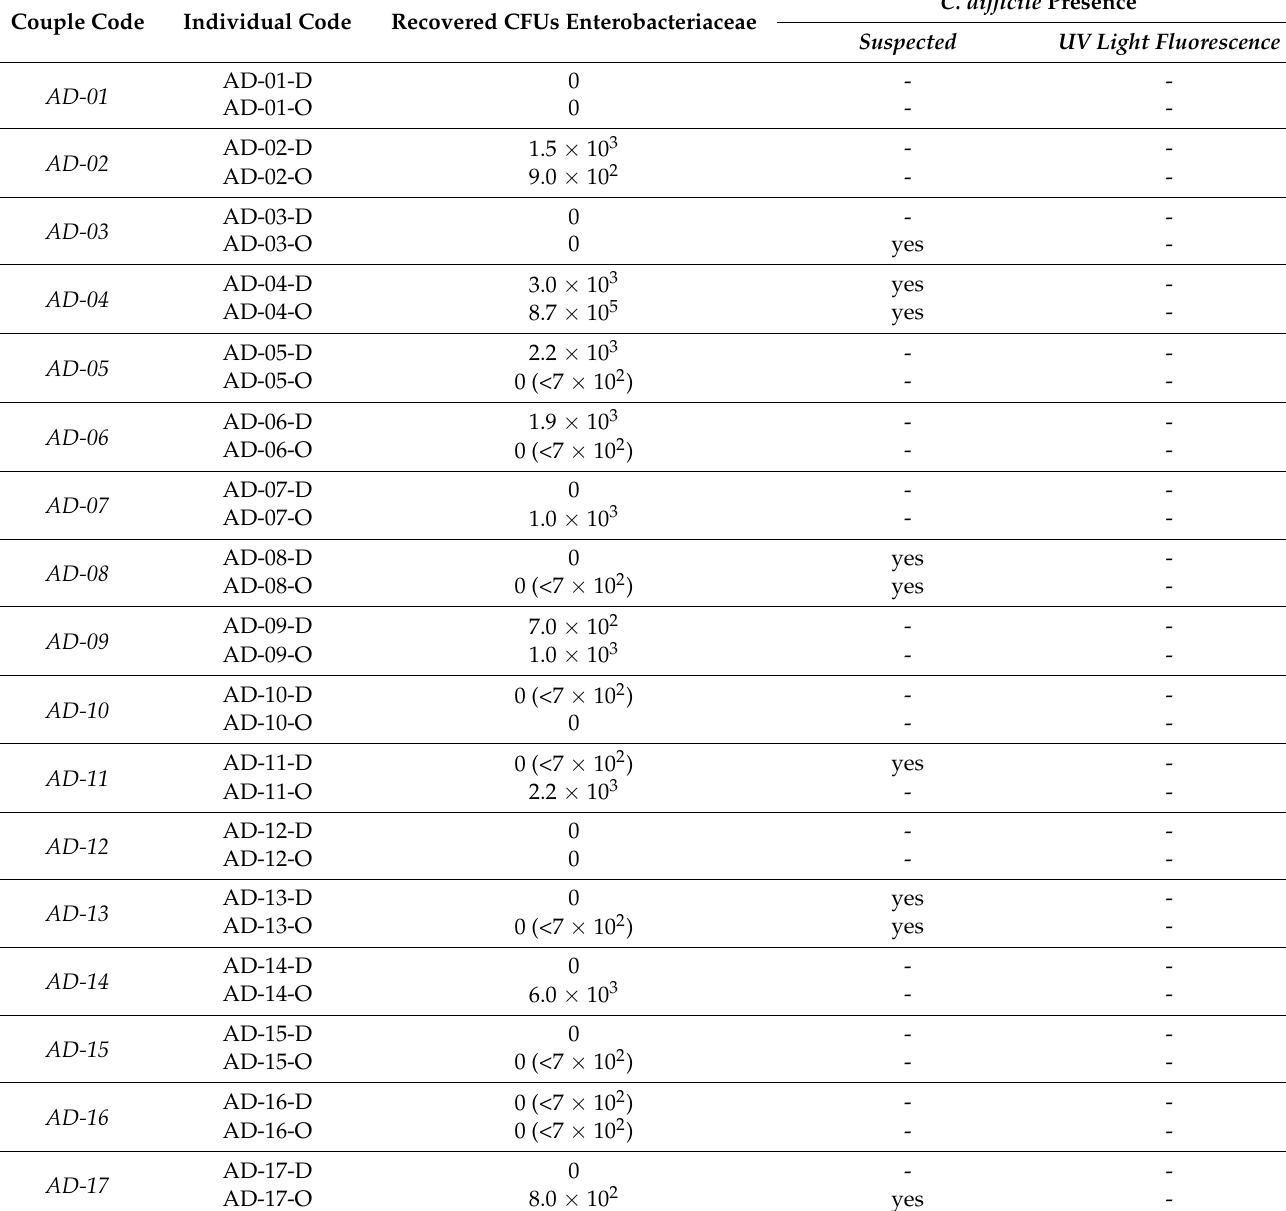
Table A1. Assistance dogs: raw microbiological analysis